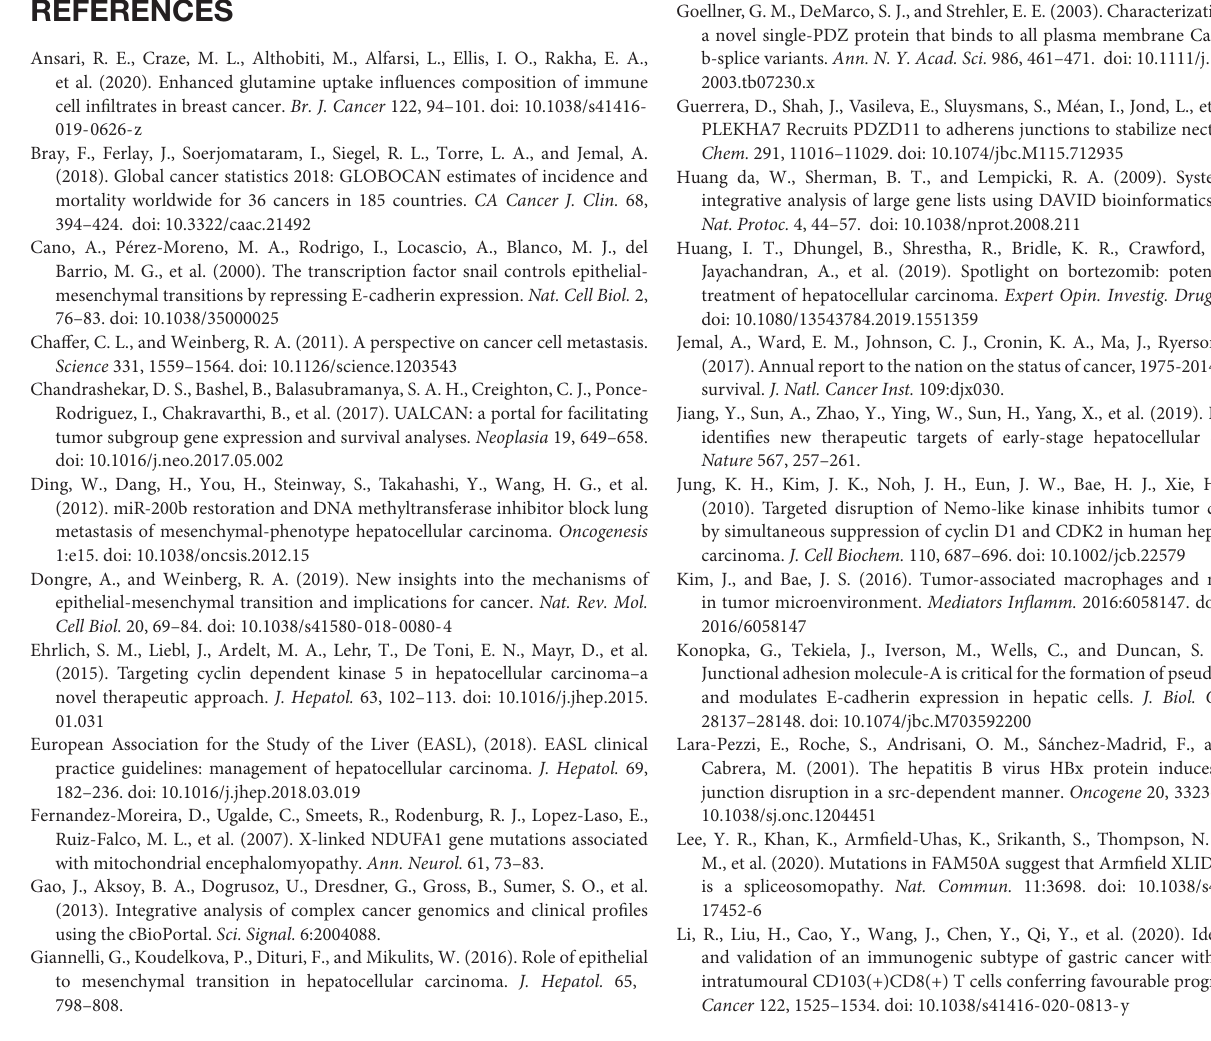
Supplementary Table 5 | Significantly enriched kinase-target networks of PDZD11 in LIHC (LinkedOmics). Supplementary Table 6 | Significantly enriched miRNA-target networks of PDZD11 in LIHC